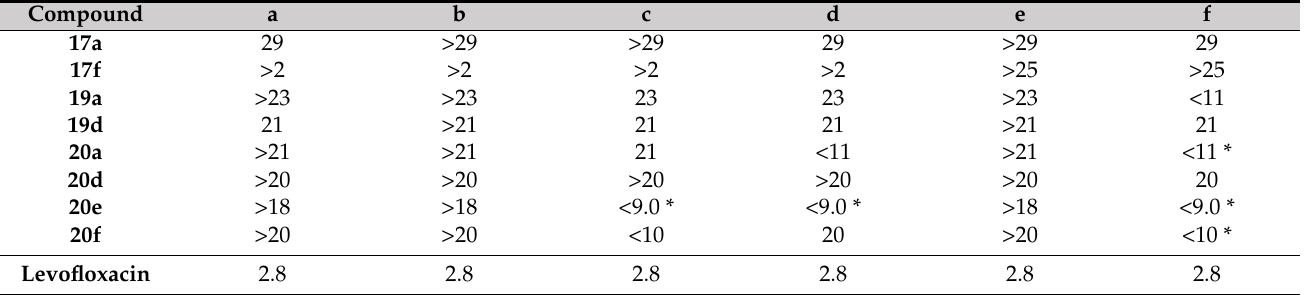
* Represents compounds with activity below (10 mg/L). a . M. tuberculosis Orphan strain. b. M. tuberculosis Haarlem. c. M. tuberculosis LAM9 SIT 42. d. M. tuberculosis Beijing. e. M. tuberculosis ATCC 35822. f. M. tuberculosis ATCC